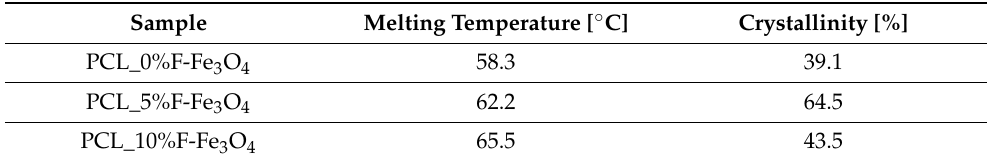
Table 2. Melting Temperature and Crystallinity of PCL-loaded membranes.